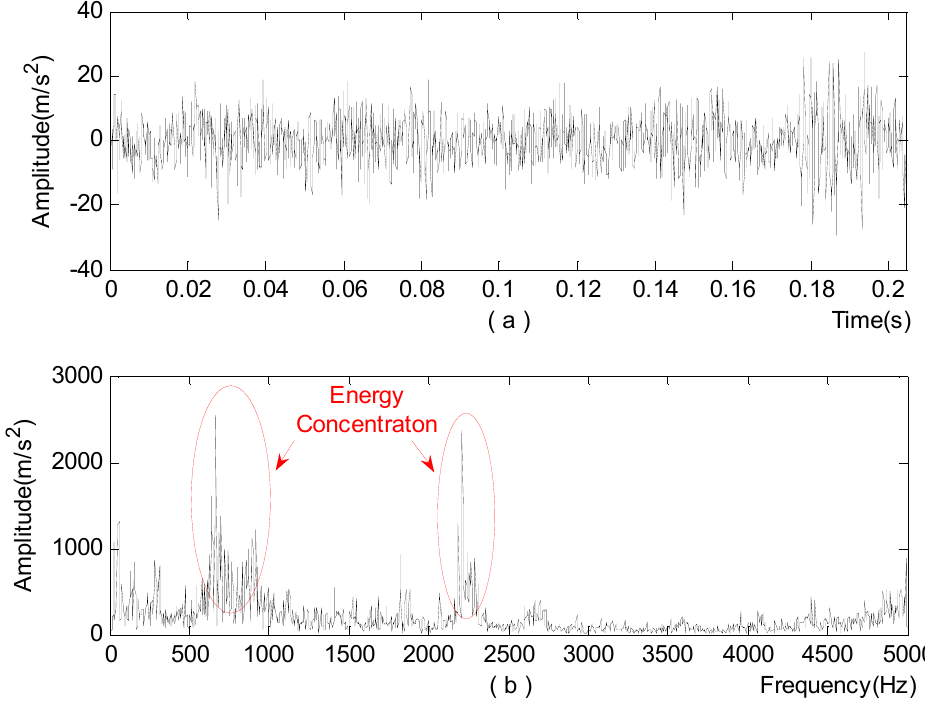
Figure 8. Analysis of vibration acceleration signals at the selected measurement point.